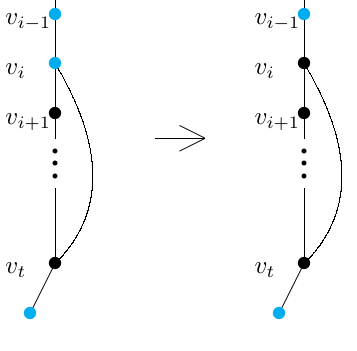
Fig. 5: Recolouring in Subcase